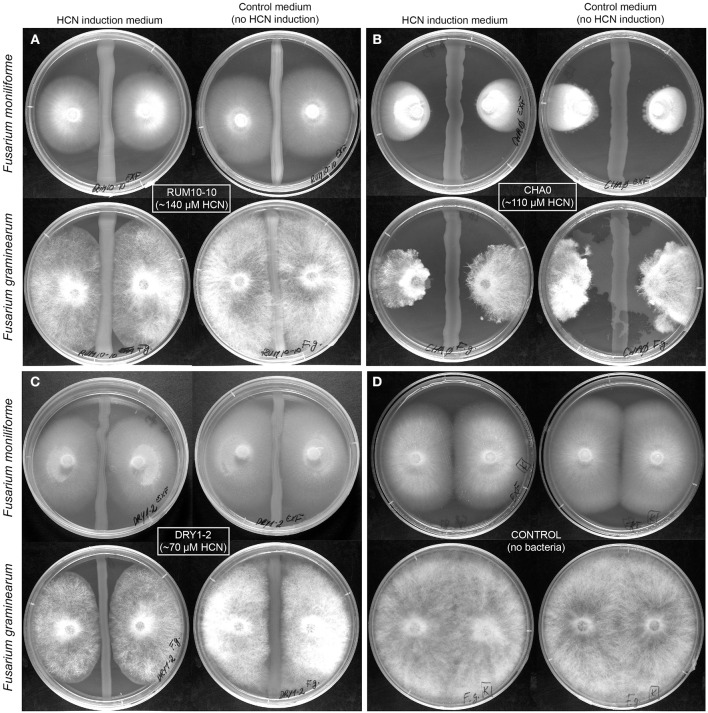
Inhibition of growth of phytopathogenic Fusarium spp. by HP isolates. Inhibition was tested on HCN induction medium, LBAgly and control medium, and LBA, not additionally inducing HCN production. Bacteria are applied to the middle of the plate in a straight line and fungi are placed on both sides as agar plugs so that the mycelium and the bacteria are not in direct contact. The distance between bacteria and fungal hyphae shows inhibition of fungal growth by bacterial strains. (A) HCN+ environmental isolate RUM10-10 (138 μM HCN in liquid culture, l.c.), (B) HCN+ strain CHA0 (107 μM HCN in l.c.), (C) HCN+ environmental isolate DRY1-2 (HCN production 66 μM in l.c.), (D) Control fungal growth without bacteria present.